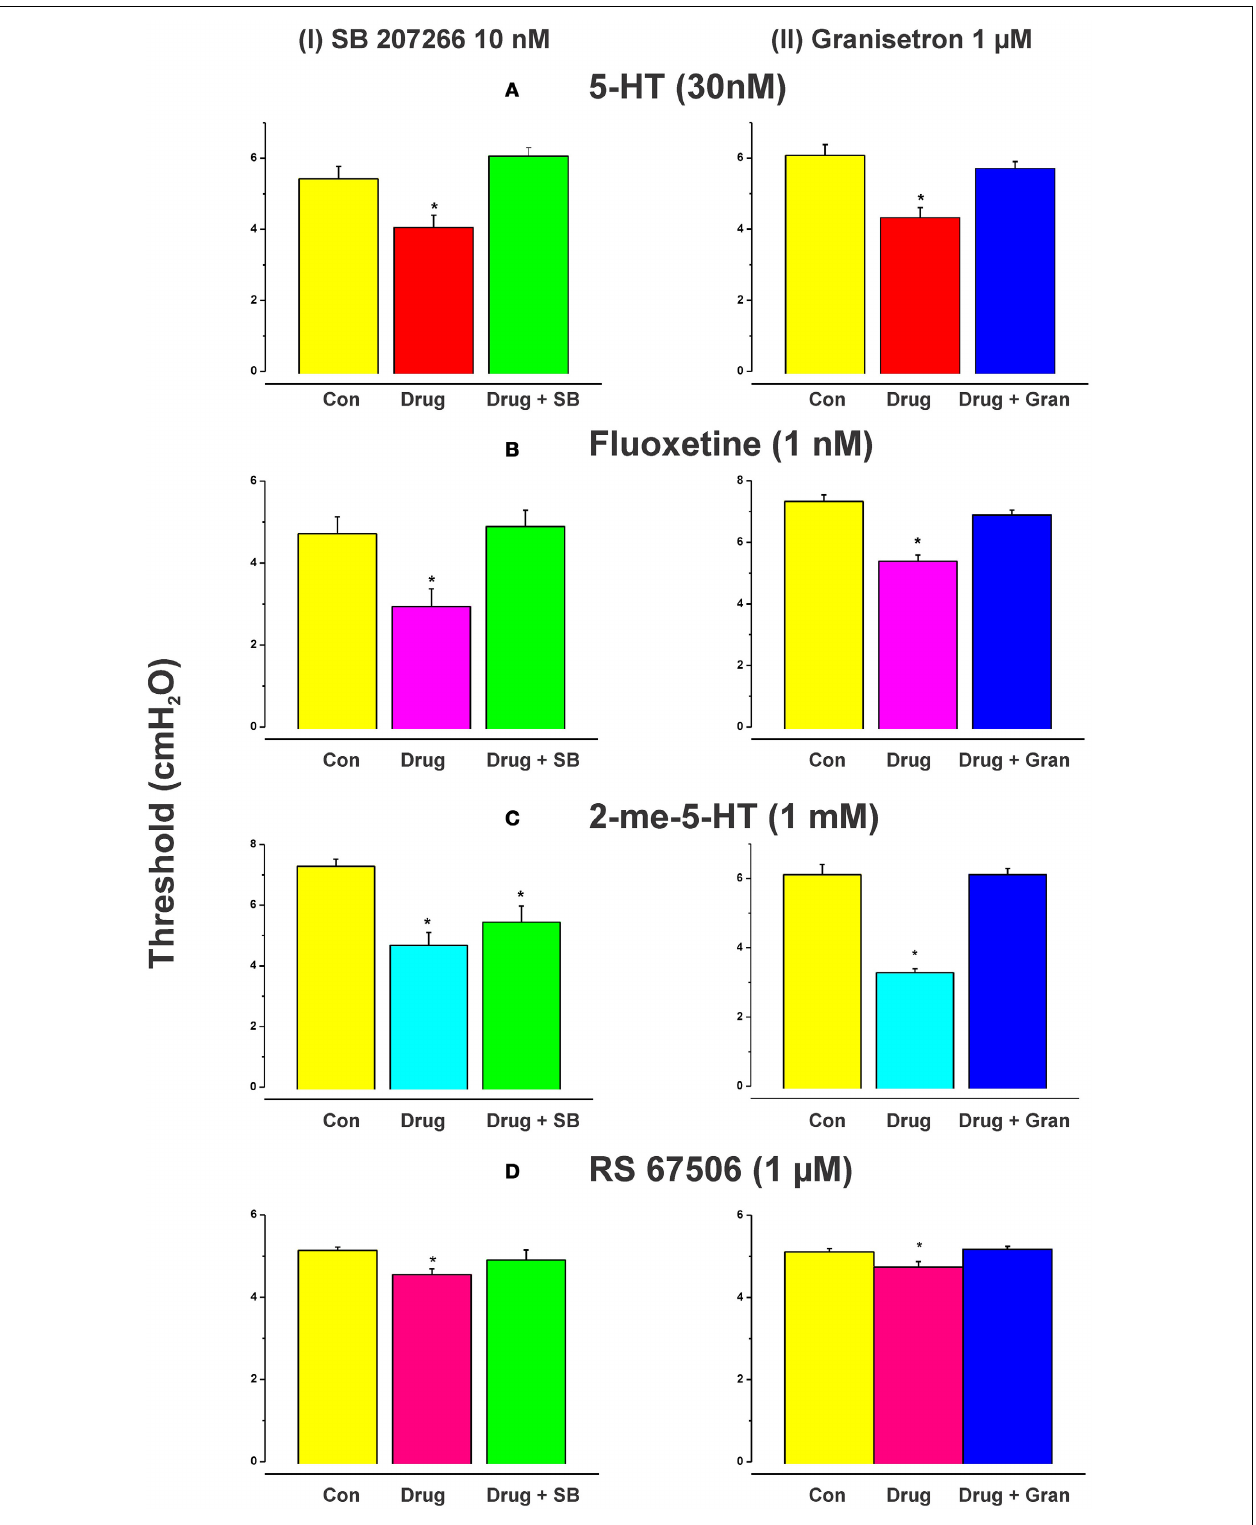
FIGURE 2 | Effects of exogenous 5-HT, endogenous 5-HT potentiated by fluoxetine, 2-me-5-HT, and RS 67506 on the threshold pressure for initiation of propulsive contractions. Histograms showing the mean ( ± s.e.m.) thresholds in cm H 2 O for initiation of peristalsis in control, with the